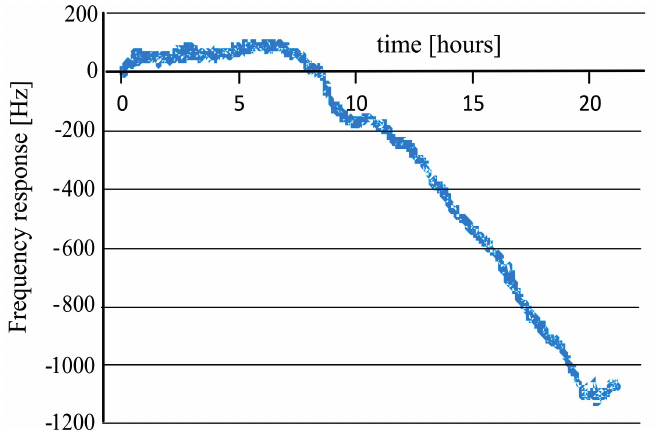
Figure 11. Measuring the growth of Bacillus subtilis from its spores by B. subtilis imprinted polyurethane, in nutrition solution of 2% ammonium sulfate and 10% glucose at temperature 42 °C and pH